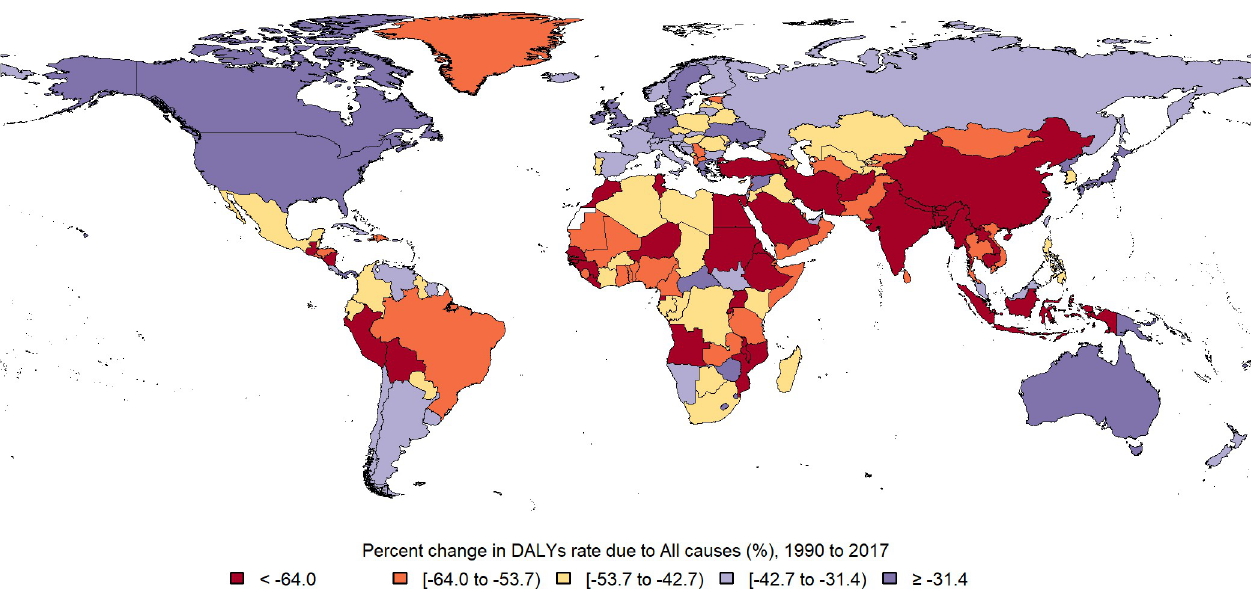
Fig 3. Time trend of Quality-of-Care Index (QCI) between 1990 and 2017.